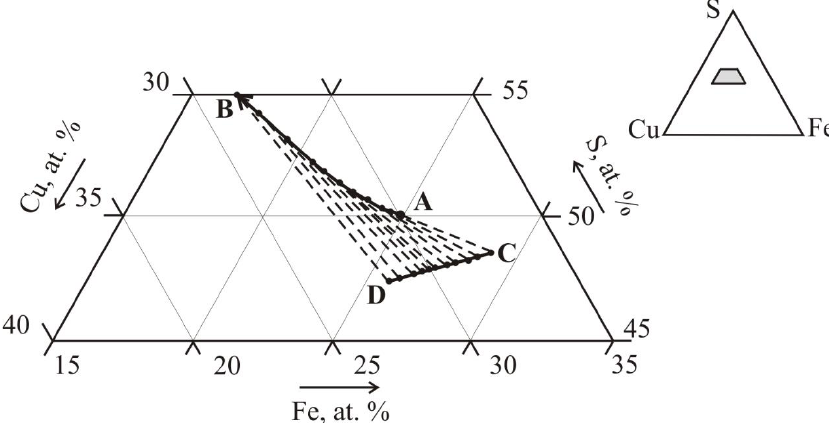
Figure 3. Displaying results of directional crystallization on the composition triangle.